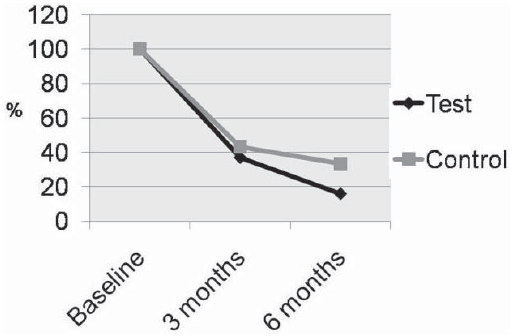
Figure 3- Percentage of furcation involvements that needed re-treatment at different time intervals for control and test